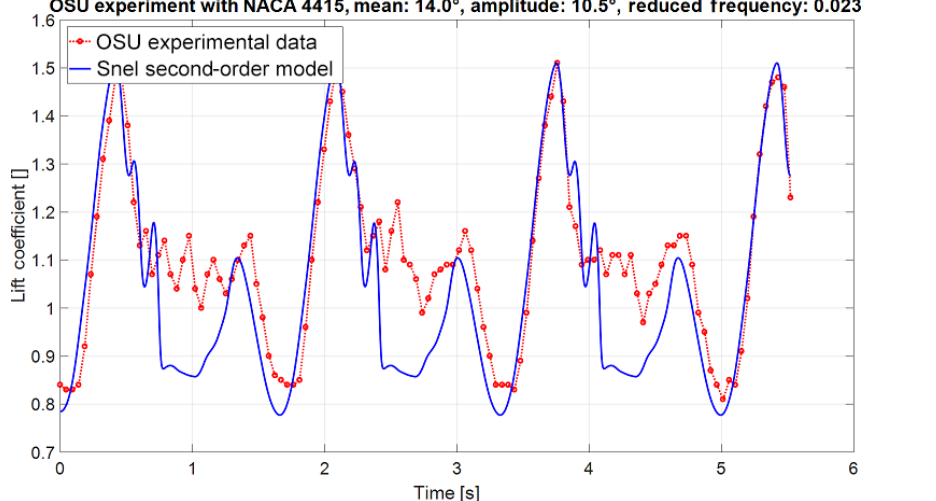
Figure 2. Lift coefficient time of the initial Snel model (NACA 4415 aerofoil with mean angle of attack of 14 ◦ , amplitude of 10.5 ◦ , and reduced frequency of 0.023).